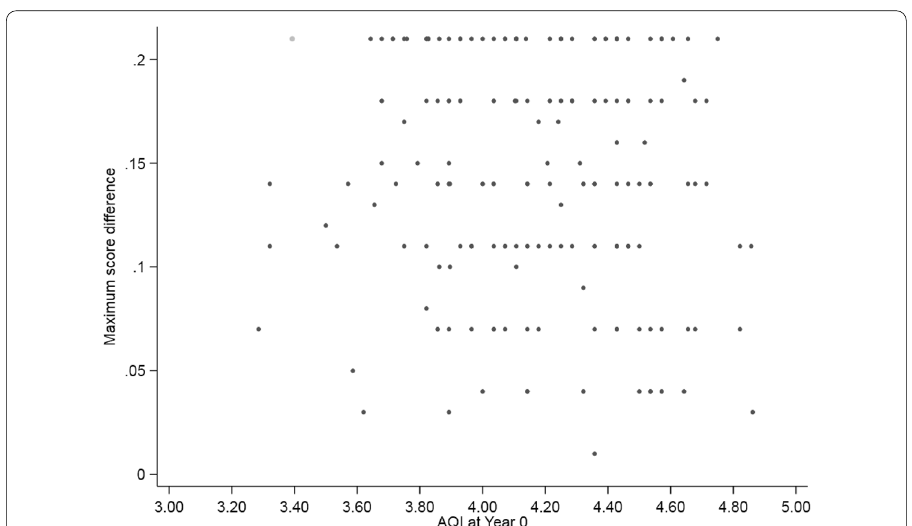
Fig. 3 Distribution of year 0 AQI scores of stable